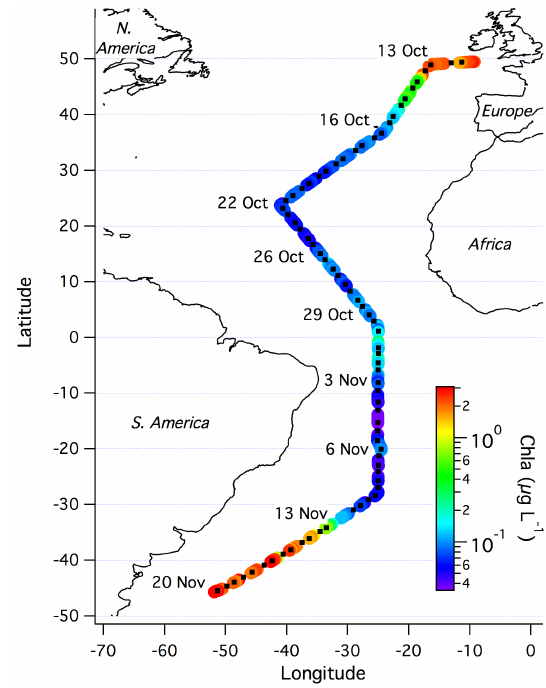
Figure 1. Cruise track of AMT-22 (2012) color-coded by chloro- phyll a concentration and marked on selected dates. The black squares indicate the locations of CTD